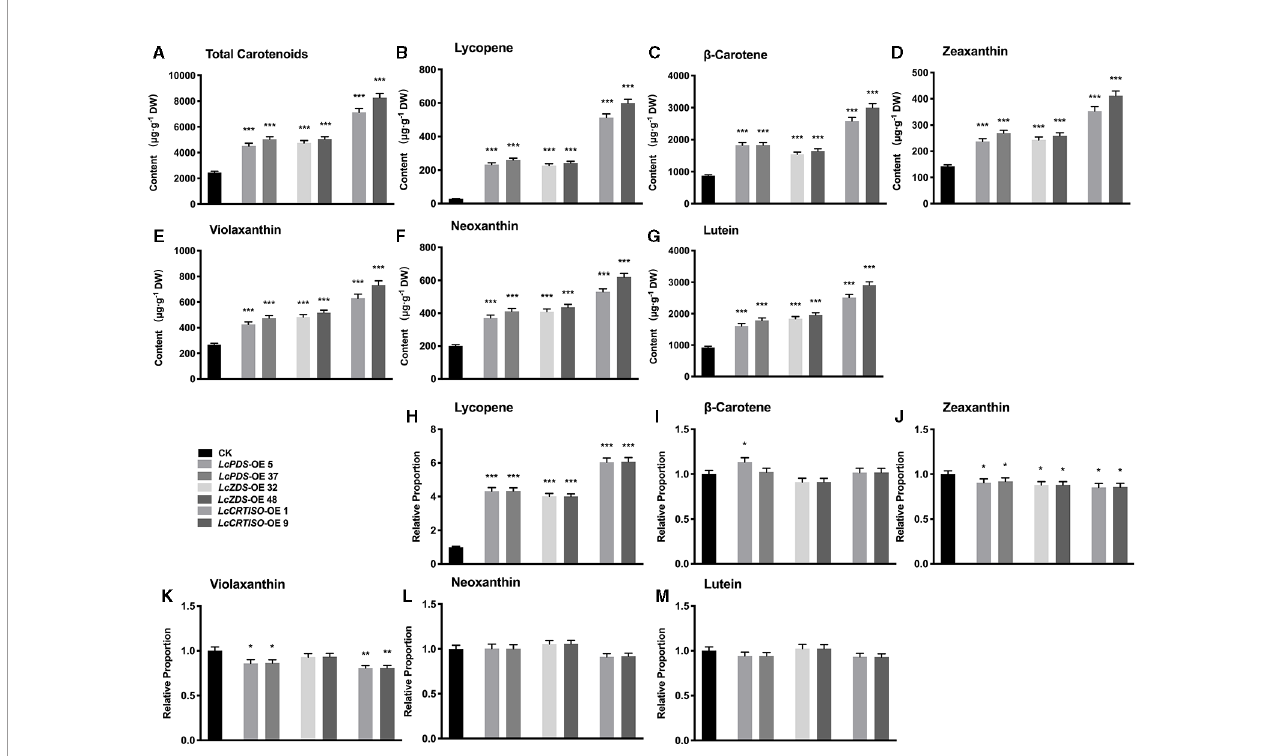
FIGURE 1 | Analysis of carotenoids in LcPDS , LcZDS , and LcCRTISO over-expressing tobacco lines with HPLC. Content of (A) total carotenoids, (B) lycopene, (C) b -carotene, (D) zeaxanthin, (E) violaxanthin, (F) neoxanthin, and (G) lutein. Relative proportion of (H) lycopene, (I) b -carotene, (J) zeaxanthin, (K) violaxanthin, (L) neoxanthin (M) lutein were analyzed in freeze-dried samples and shown as fi gure. Data were obtained from three independent experiments and one-way analysis of variance (ANOVAs) was performed. The results were presented as means ± standard deviation (SD). P values of < 0.05 (*), < 0.01 (**), and < 0.001 (***) were considered to be signi fi cant